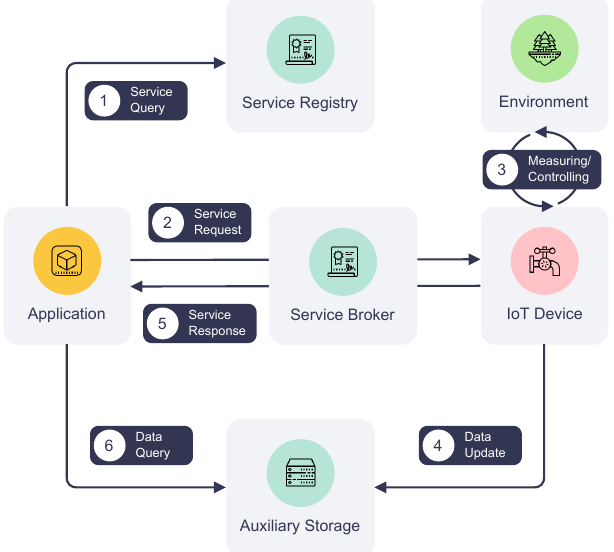
Figure 4. Process of communication between an IoT device and